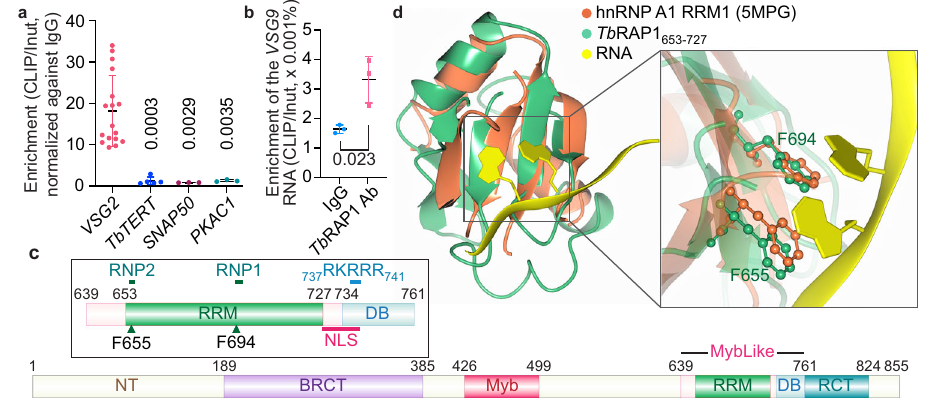
Fig. 1 | Tb RAP1 binds the active VSG RNA in vivo and contains an RNA Recognition Motif (RRM) domain. a RNA CLIP experiments were performed in TbRAP1 F2H+/- cells that express VSG2. qRT-PCR was performed to estimate the amountofthe VSG2 RNAandthe TbTERT,SNAP50 ,and PKAC1 RNAsintheRNACLIP product. Enrichment of the VSG2, TbTERT, SNAP50 , and PKAC1 RNAs (CLIP/Input) wascalculatedfortheCLIPexperimentusingtheHAantibody12CA5andthatusing IgG. Relative enrichment was calculated using the enrichment of IgG CLIP as a reference. Average and standard deviation were calculated from three ( SNAP50 & PKAC1 ), fi ve ( TbTERT ),andseventeen ( VSG2 ) independent experiments. P valuesof two-sided unpaired t -tests (compared to VSG2 RNA enrichment) are shown. b RNA CLIP was performed in VSG9-expressing PVS3-2/OD1-1 cells using a Tb RAP1 rabbit